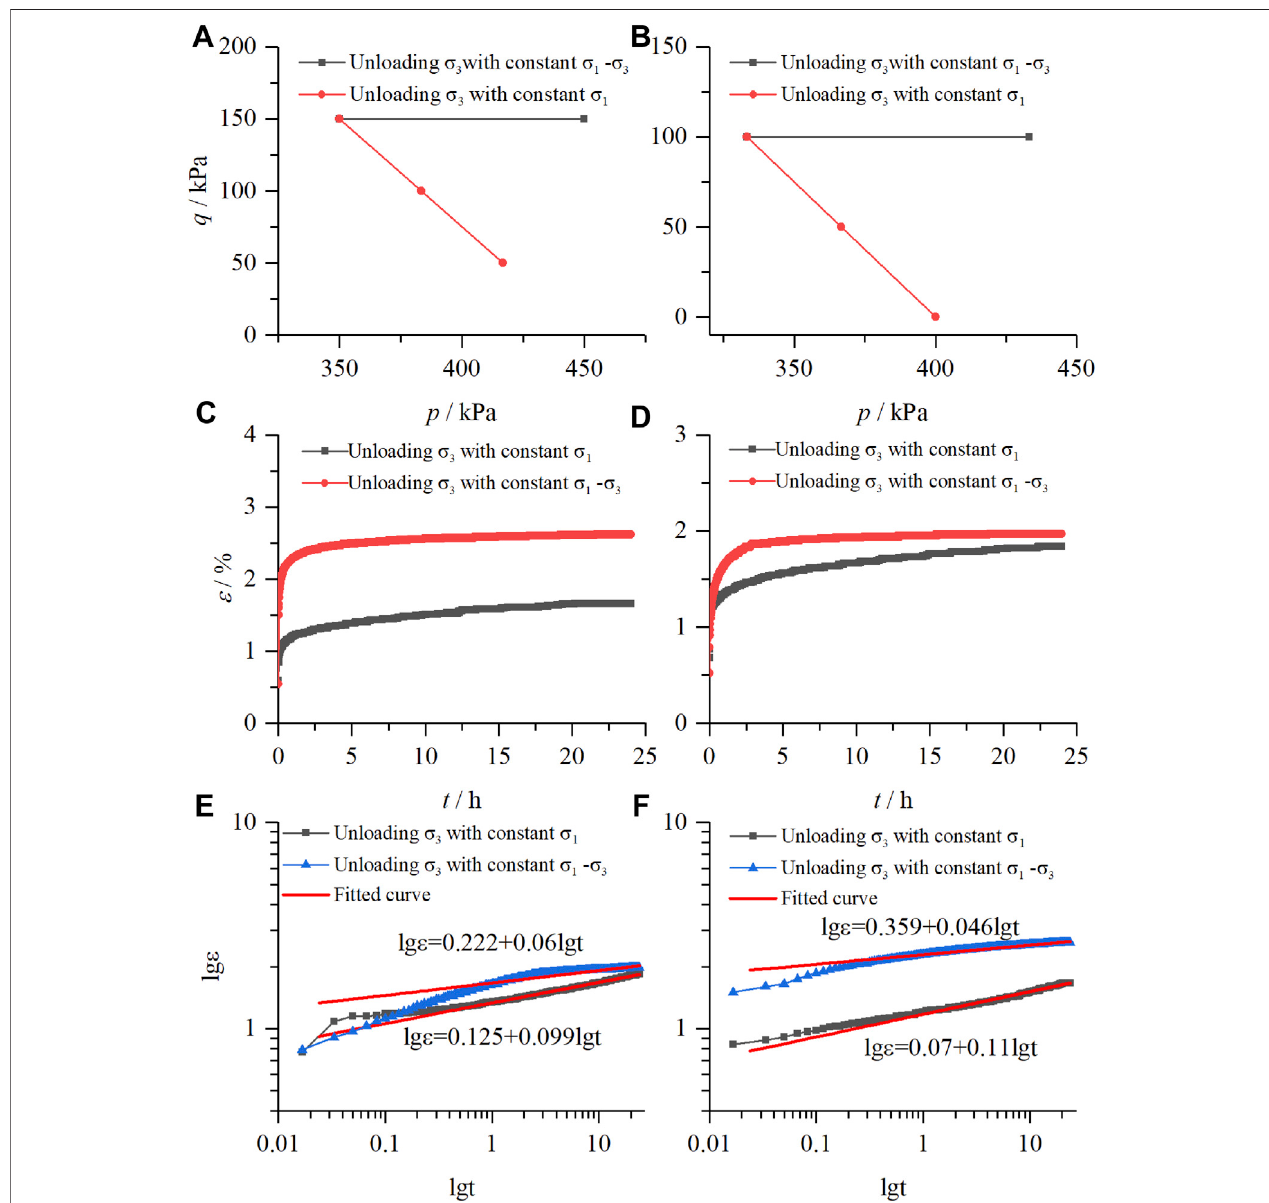
FIGURE 10 | Comparison of unloading the con fi ning pressure in steps with constant deviator stress and unloading the con fi ning pressure in steps with constant principal stress, (A) (B) the relationship of mean net stress and deviator stress, (C) (D) strain-time curves, (E) (F) double logarithmic curves of strain time.